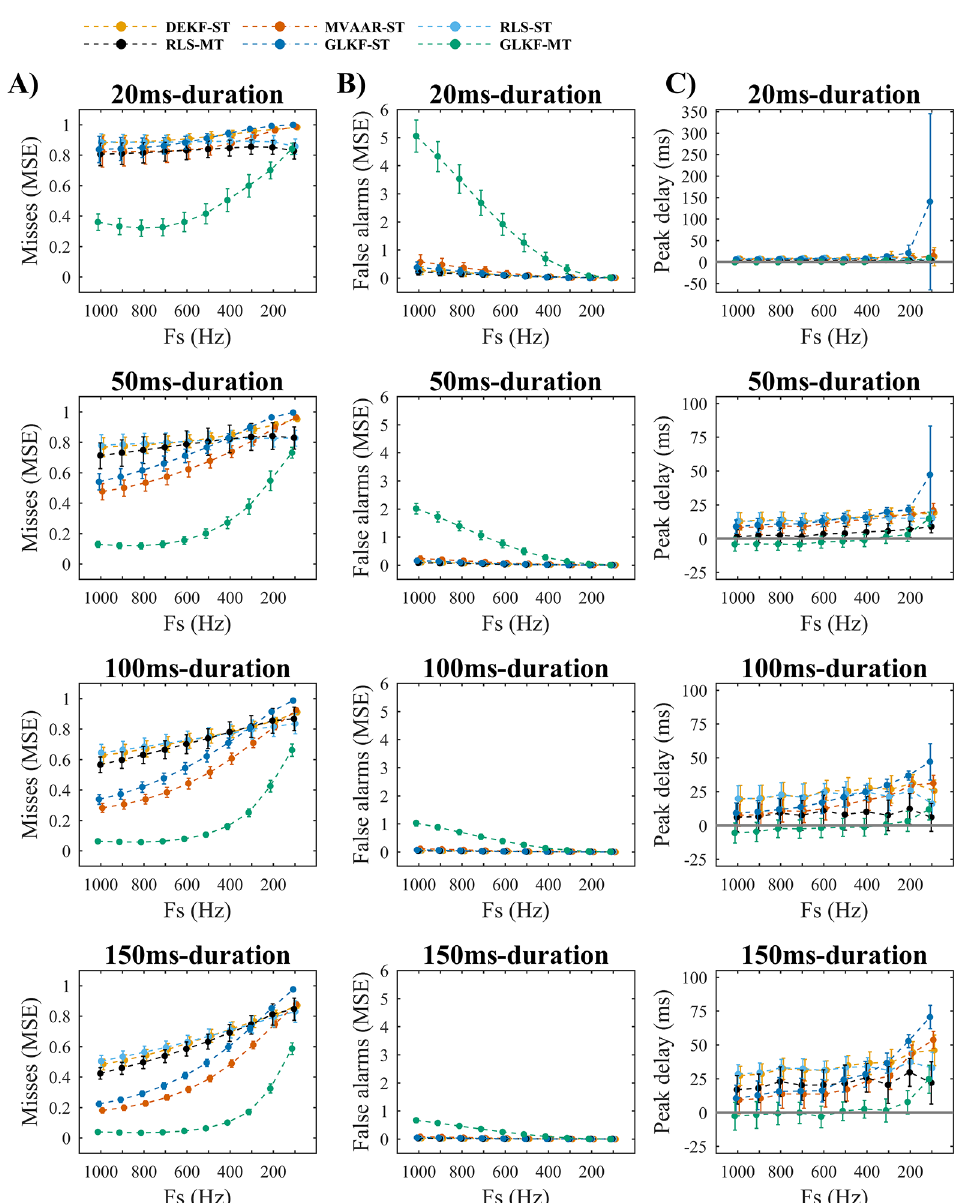
Fig 6. Simulation 3 on the effects of varying sampling rate: Connectivity estimation. A) Shows the misses (normalized MSE), which are computed on the edge from node 1 to node 2 (Fig 1C). B) Shows the false alarms (normalized MSE), which are computed on the edge from node 2 to node 1 (Fig 1C). C) Shows the peak delay, which is computed as difference between peak latencies of estimated and simulated causal influence from node 1 to node 2 (Fig 1C). The results are shown for four different durations of the imposed causal influence from node 1 to node 2 (Fig 1D): 20 ms (first row), 50 ms (second row), 100 ms (third row), and 150 ms (fourth row). In each plot the results are reported varying sampling rate Fs, for the four recursive algorithms and the two ways of exploiting multiple trials: single-trial modeling and multi-trial modeling, available only for RLS and GLKF. Error bars represent 95% CI of the mean value computed across 50